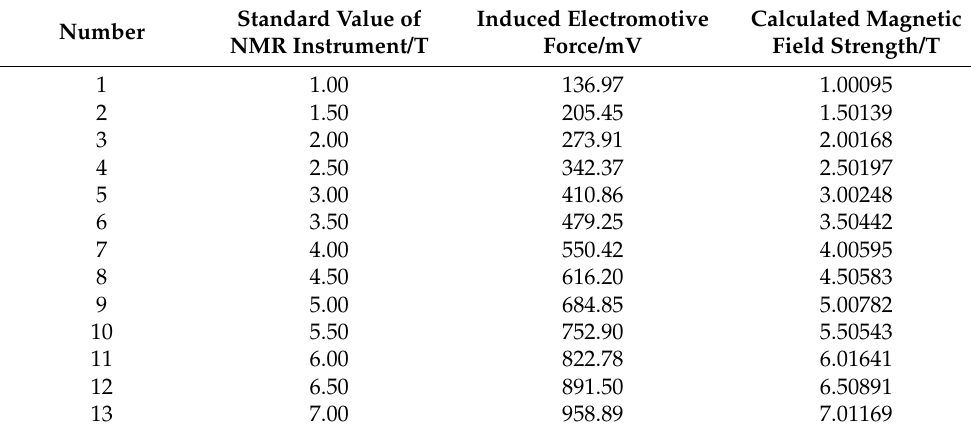
Table 3. Magnetic field measurement